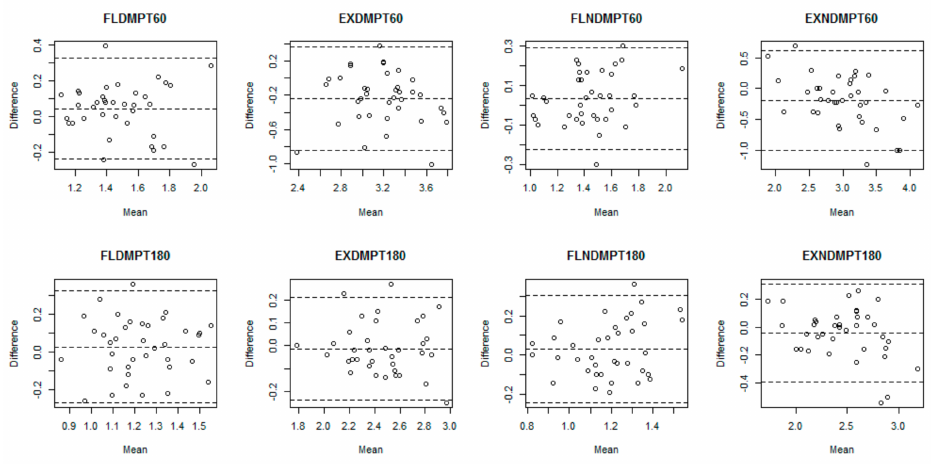
Figure 3. Bland–Altman plots for the inter-rater reliability of Trial 1, based on the mean of two dynamometers in eight measures. The first dashed line represents Mean–1.96 × SD, the second dashed line represents Mean, and the third dashed line represents Mean + 1.96 × SD. The grey circles indicate differences beyond the 95% confidence